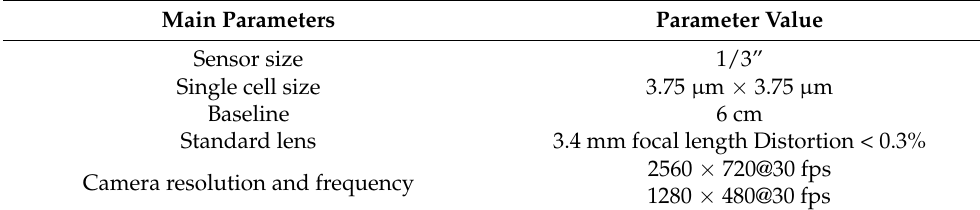
Table 3. The parameters of the binocular camera.